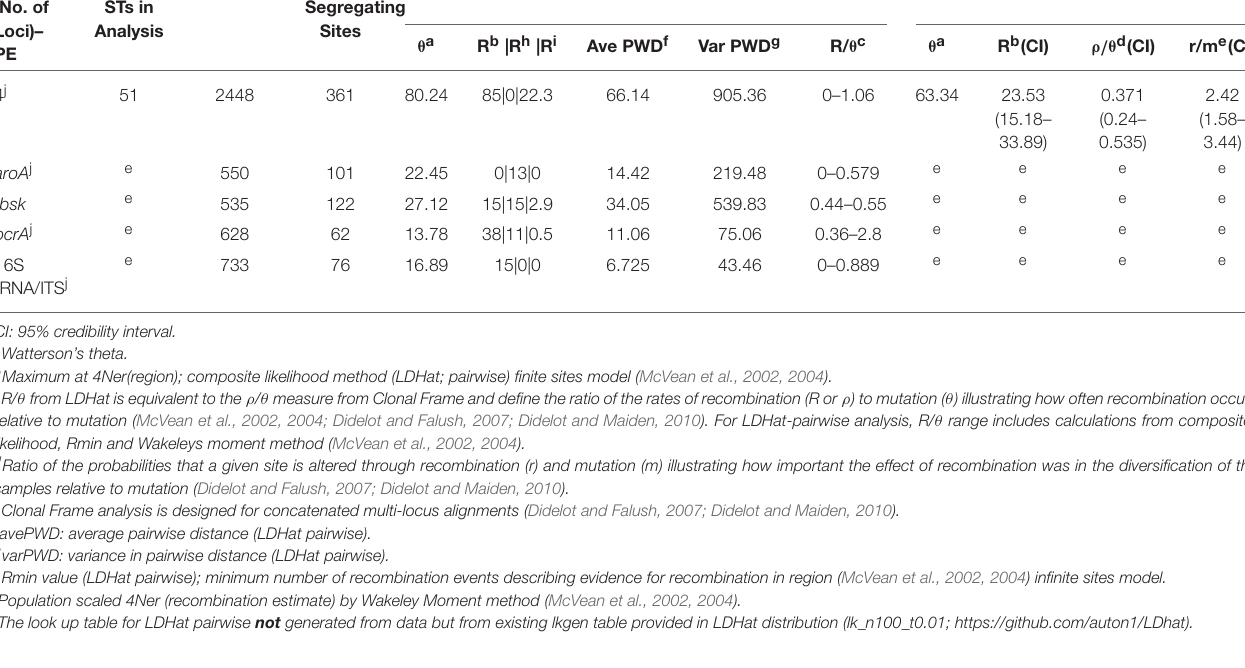
TABLE 2 | Results from recombination and mutation rate and ratio analyses for B’-like Synechococcus BACs. Locus (No. of Loci)–